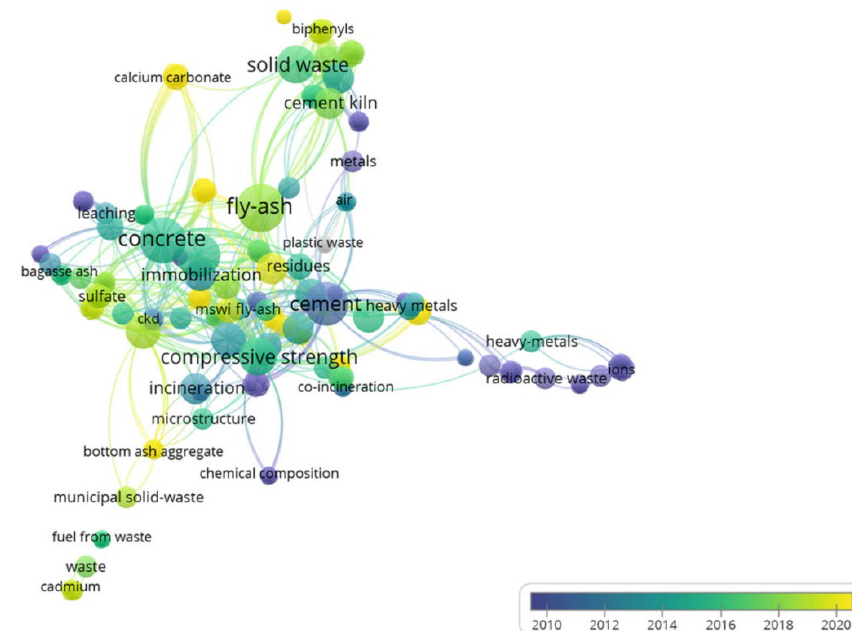
Figure 6. Keywords overlay visualization graphics of publications.